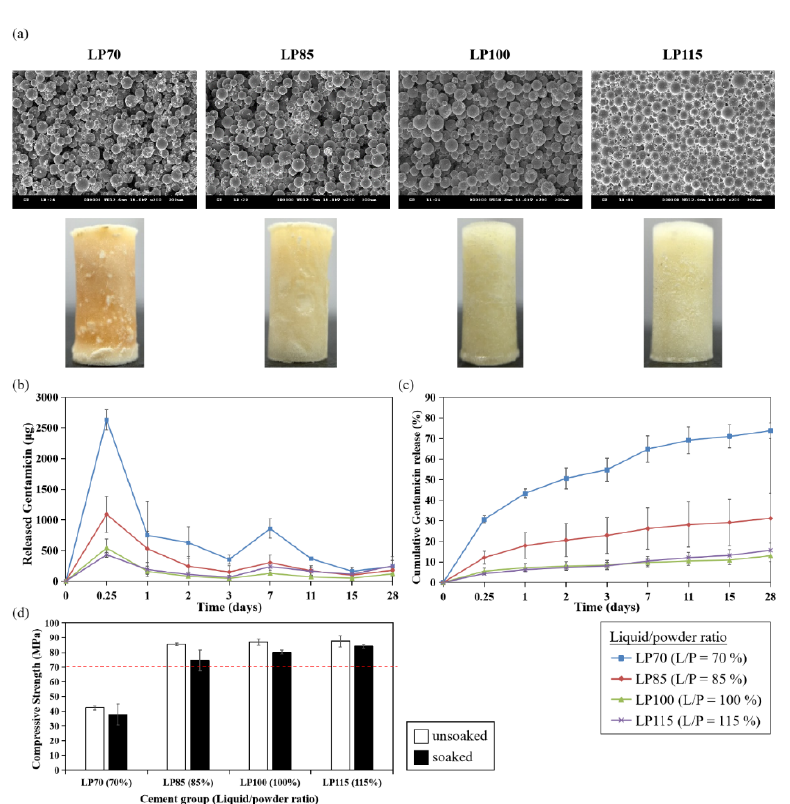
Figure 4. Effects of liquid/powder ratio on antibiotics elution and compressive strength of PMMA bone cement. ( a ) SEM images and morphology of PMMA cement. ( b ) Gentamicin elution profile. ( c ) Cumulative gentamicin release percentage. ( d ) Compressive strength. White bar: unsoaked cement; black bar: PBS-soaked cement. The dashed line indicates the ISO standard for compressive strength (70 MPa).